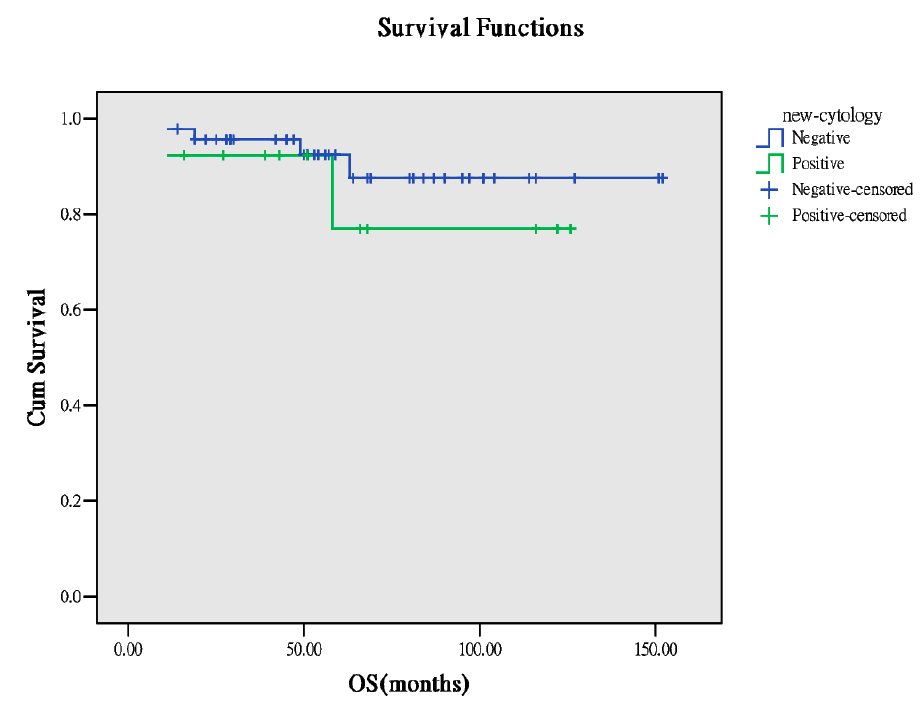
Figure 6. OS between the cytology results ( p = 0.446) .